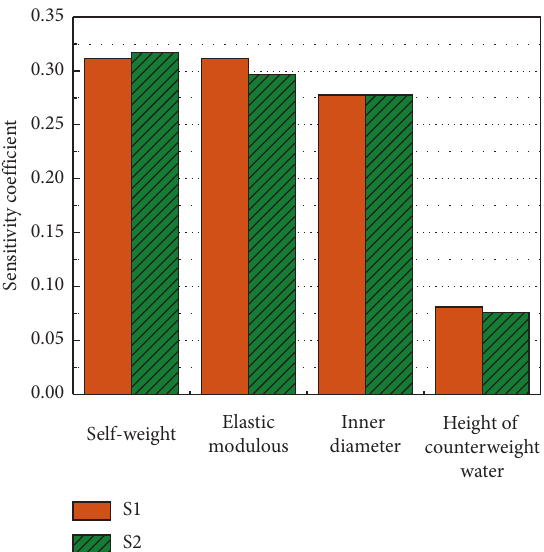
Figure 7: Relationship between self-weight per unit length of shaft and critical depth.